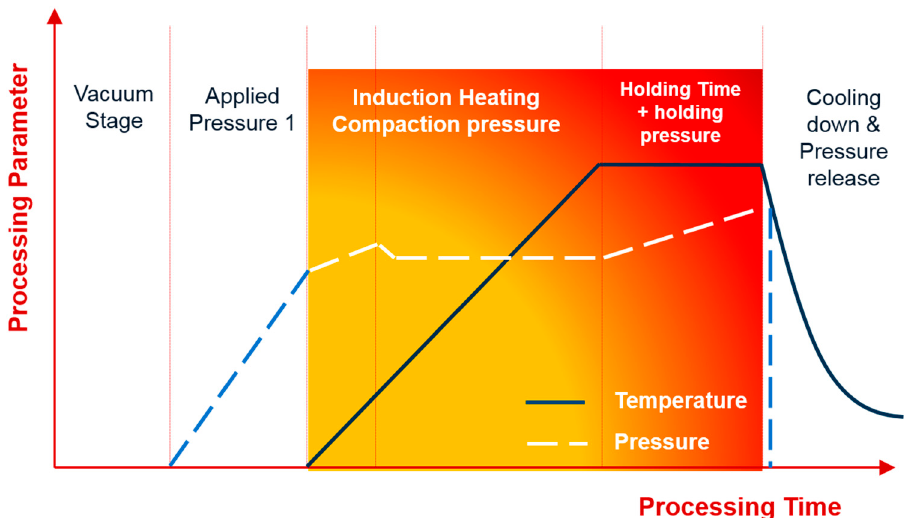
Figure 11. The 5 major stages of sintering process in the HFIHS machine.